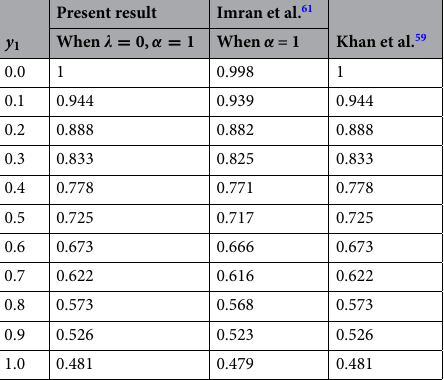
Table 5. Comparisons of dimensionless velocity.